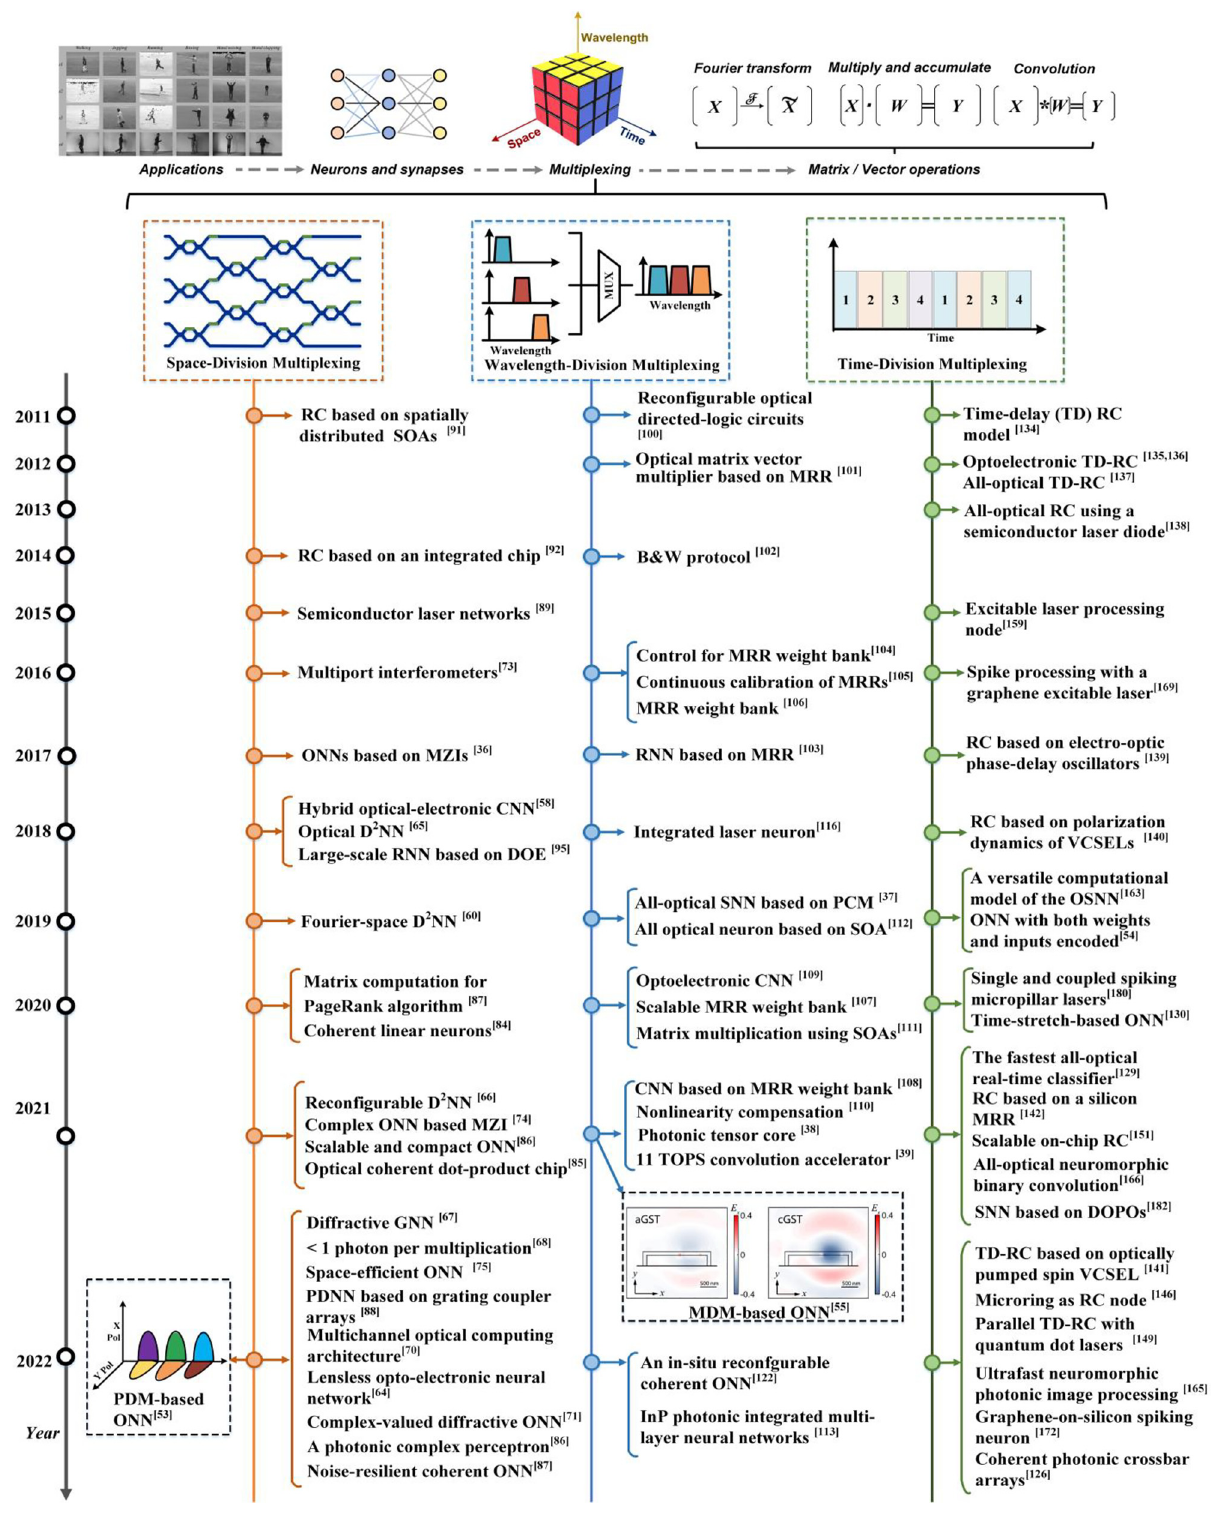
Figure 3: Approaches to optical neural networks using different multiplexing